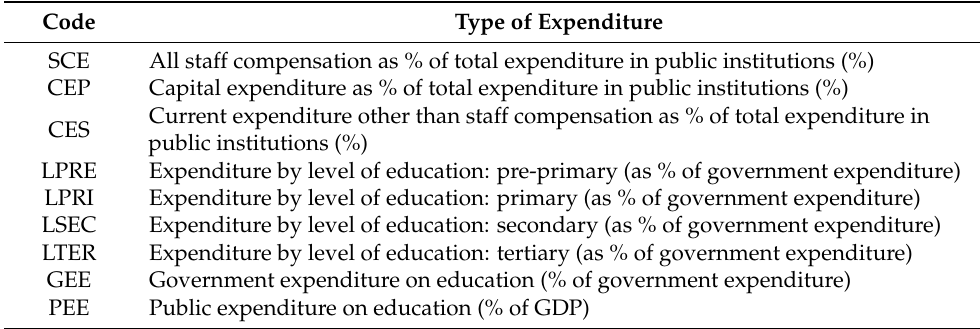
Table 1. List of the codes of public expenditures on